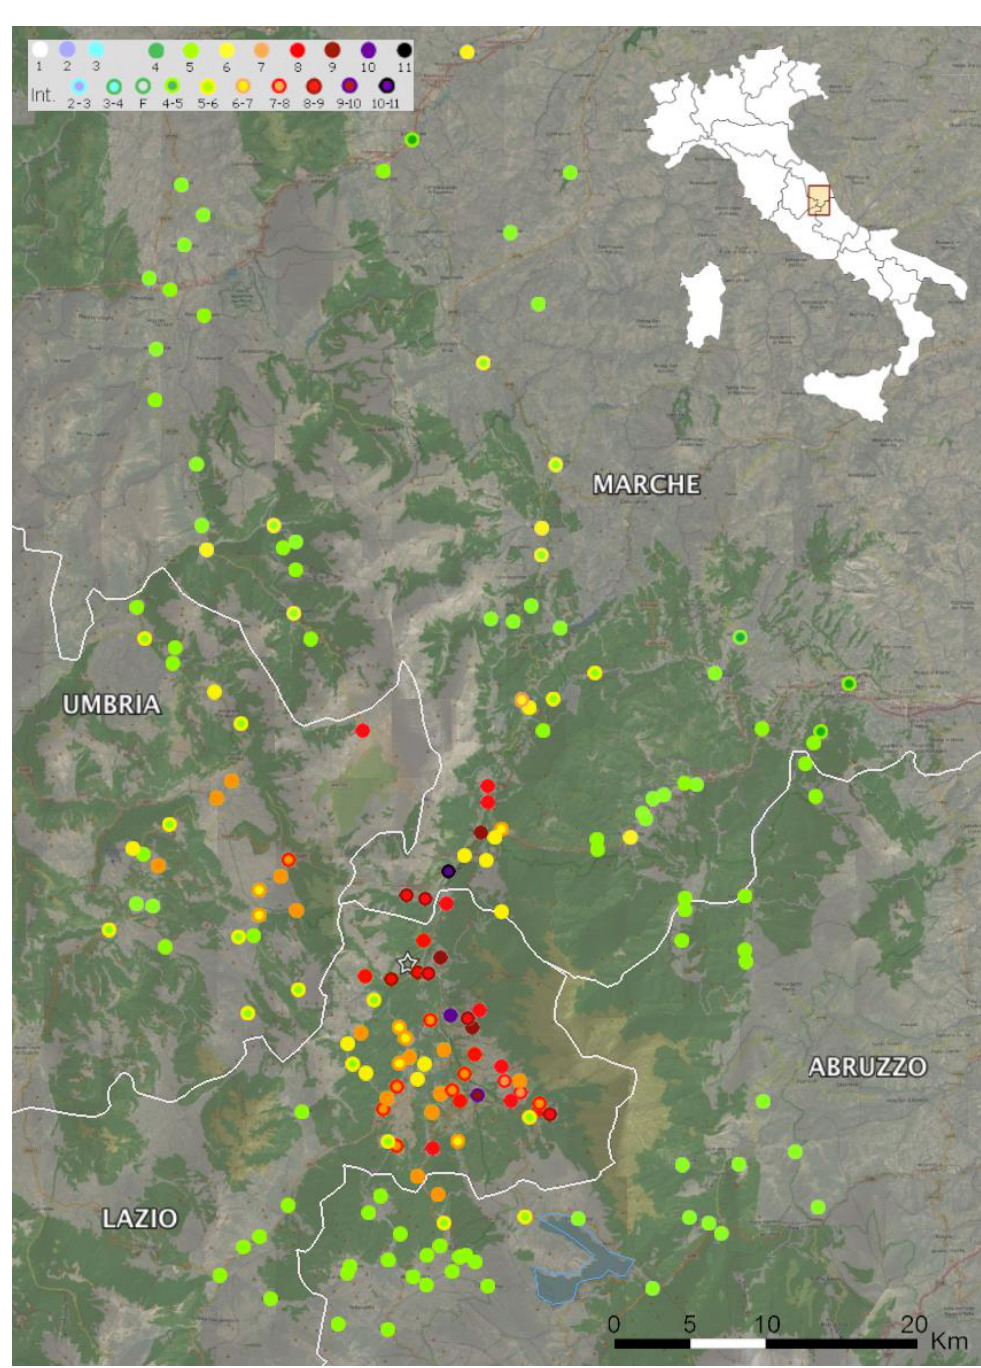
Figure 1: Macroseismic intensities observed after the August 2016 seismic sequence (damage up to September 6,